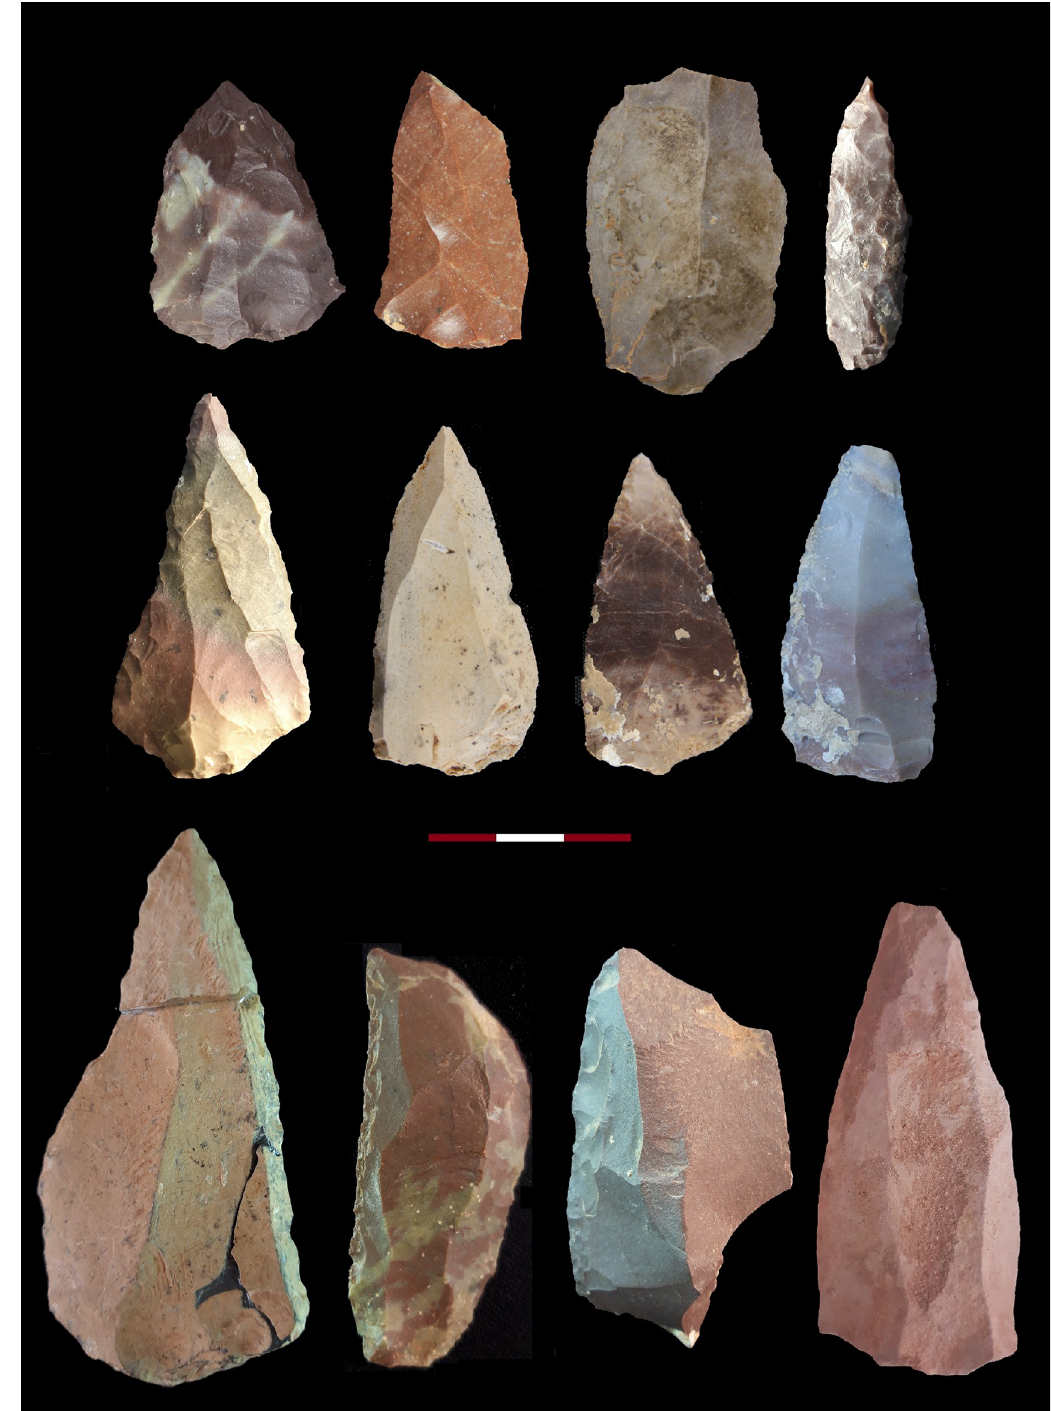
Fig 5. 1, 5, 7–9. Convergent scraper, 2.3.6,12. Levallois flake, 4. Limace, 10. Double scraper, 11. Single scraper.